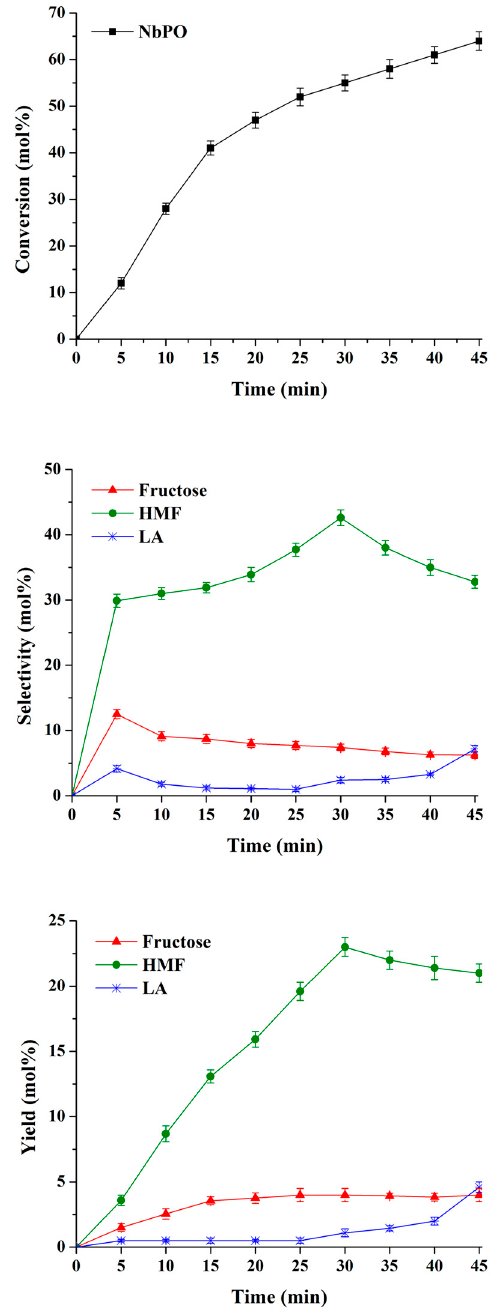
Figure 3. MW-assisted conversion of glucose in the presence of NbPO as acid catalyst at 160 ◦ C. Reaction conditions: glucose = 0.25 g; catalyst = 0.21 g; water = 4.8 g, T = 160 ◦ C. Note: where the error bars are not visible, they are smaller than the symbols.